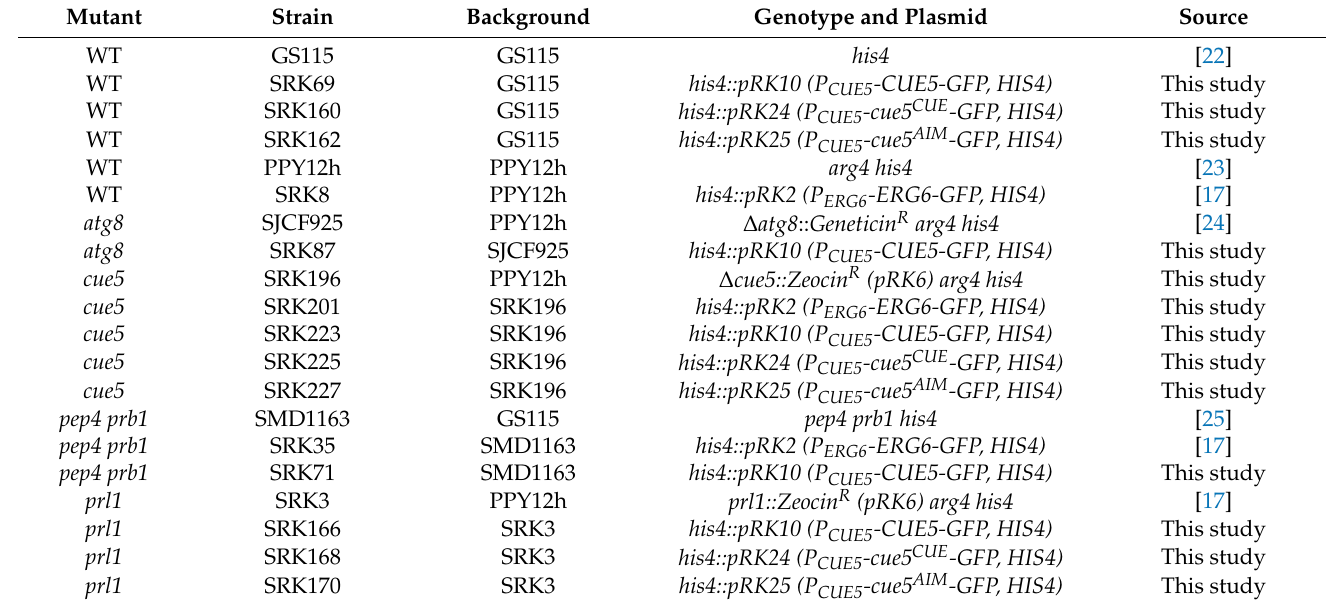
Table 1. K. phaffii strains and plasmids used in this